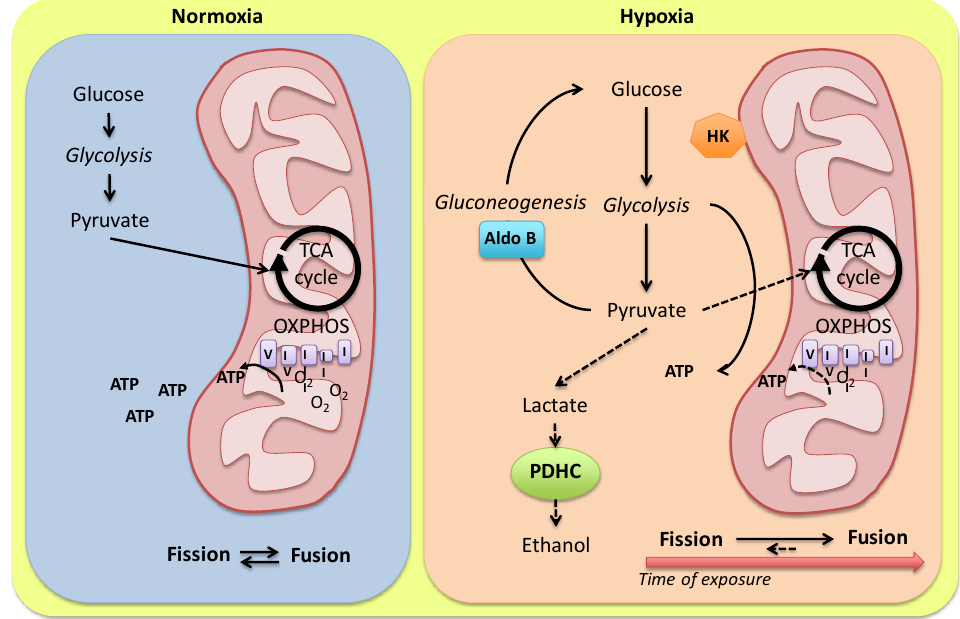
Figure 1. Model for alternative routes of pyruvate metabolism in the Carassius auratus heart. In the presence of O 2 , pyruvate from glycolysis is converted to acetyl-CoA and addressed to mitochondria for the oxidative phosphorylation. Under hypoxia, a tight modulation of glycolysis enzymes may finely regulate anaerobic ATP production by modulating glycolytic vs. gluconeogenic flux. Pyruvate conversion to ethanol is reduced by a low cardiac expression of alternative PDHC sub-units (see the text for details). A hypoxia-dependent modulation of mitochondria dynamics in relation to the exposure time is proposed. HK: hexokinase; Aldo B: aldolase B; PDHC: pyruvate dehydrogenase